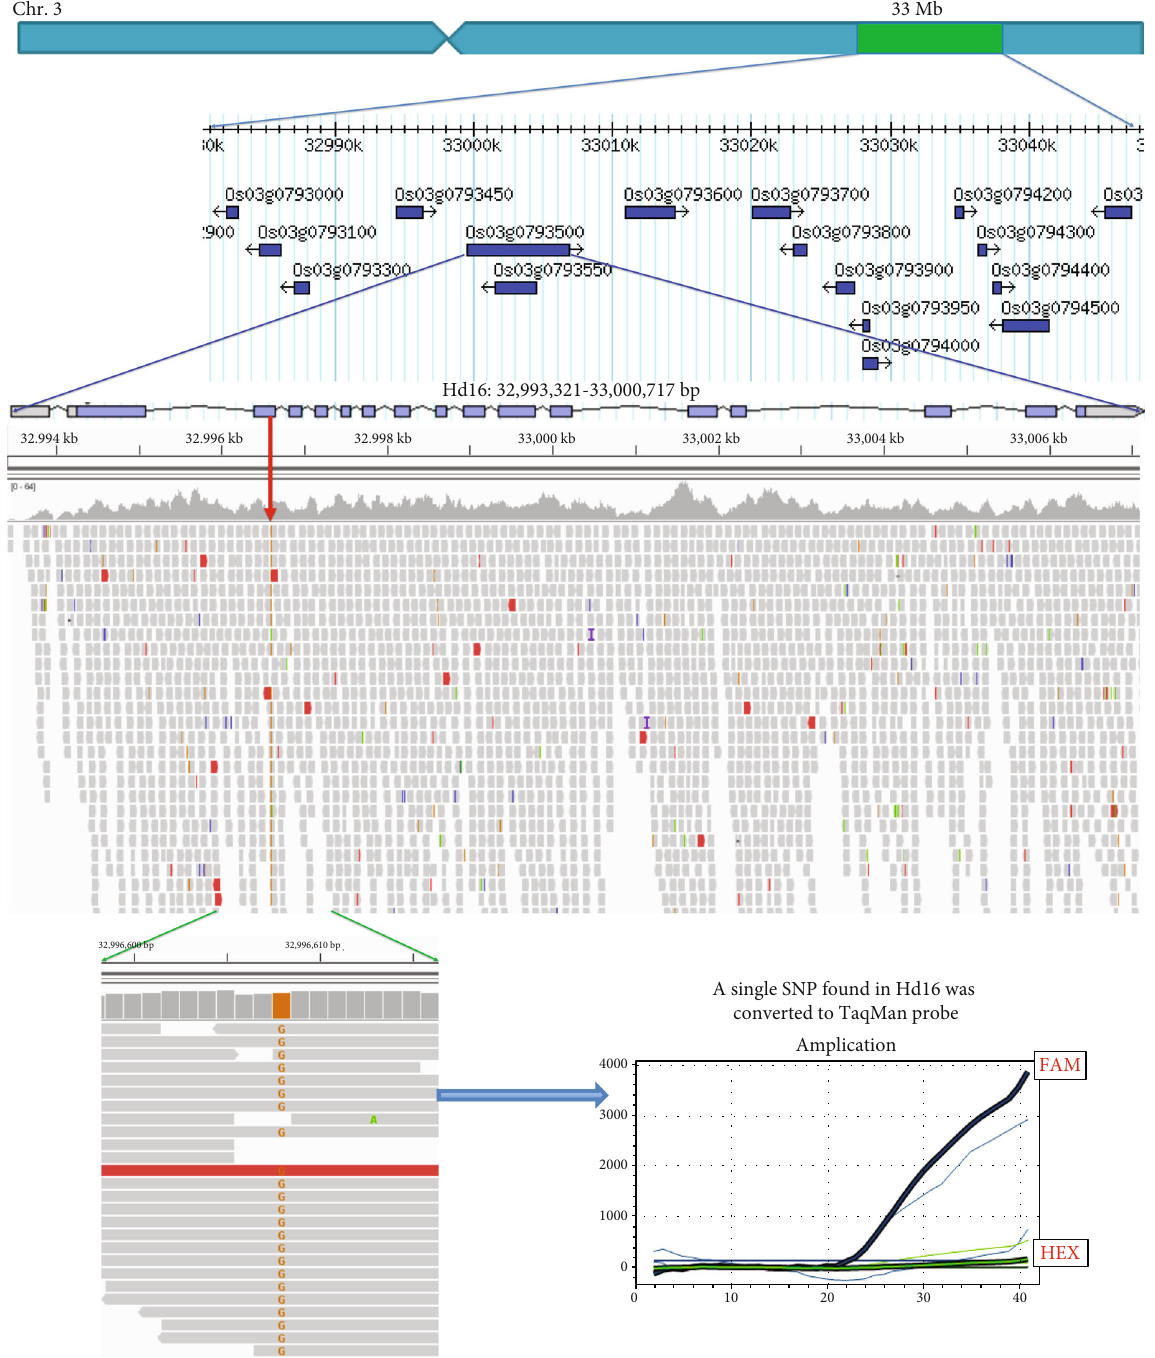
Figure 5: Identi fi cation of a single nucleotide substitution in Hd16 (Os03g0793500) responsible for the late maturity of isogenic Koshihikari derived from Isehikari. In the region between linked SSR markers, only a single SNP in Hd16 gene encoding casein kinase I was detected in several annotated coding sequences. The SNP was the same as that of Hd16 gene in Nipponbare. TaqMan probe speci fi c to Hd16 allele labeled with FAM detected the SNP. The TaqMan probe for the SNP is useful for practical MAS